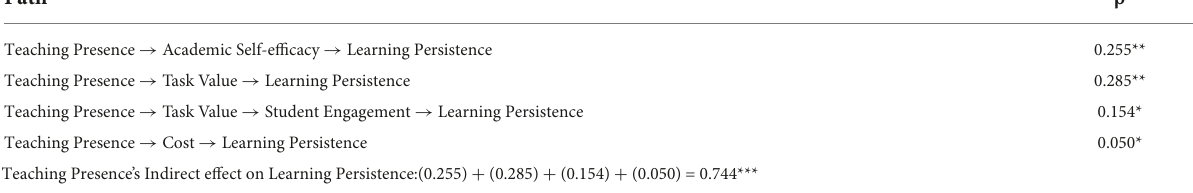
TABLE 3 Individual mediating effect analysis results between teaching presence and learning